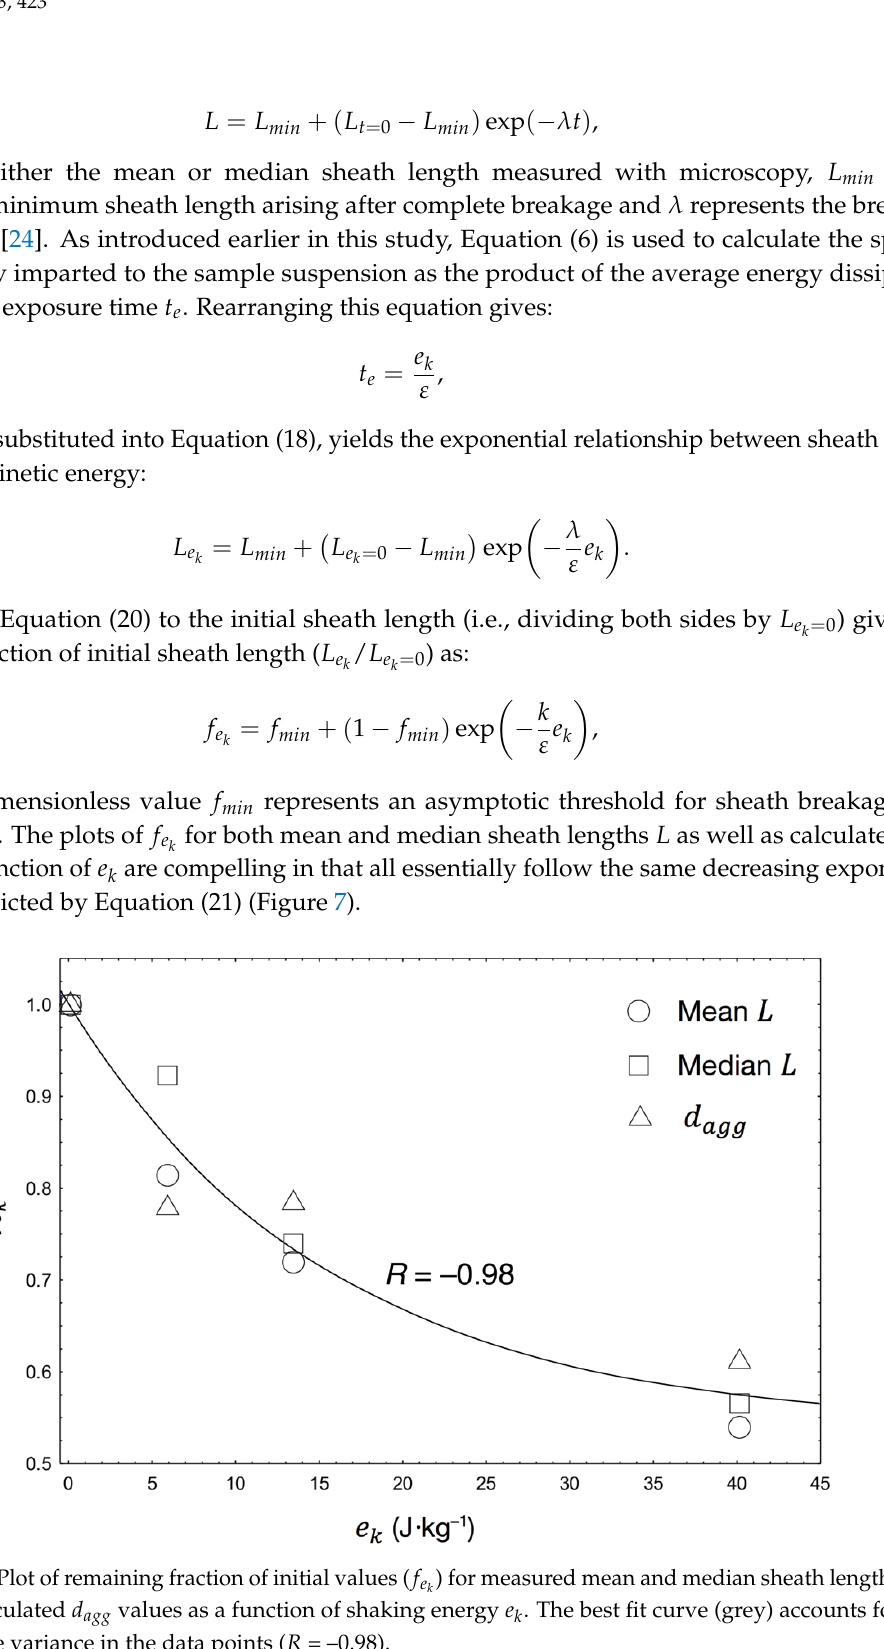
) for measured mean and median sheath lengths k